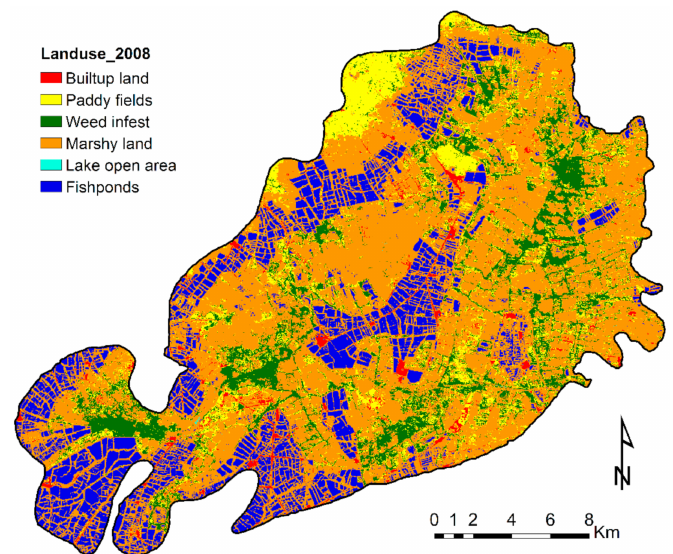
Figure 6. The 2008 land-use map of the Kolleru Lake wetland based on supervised classification.